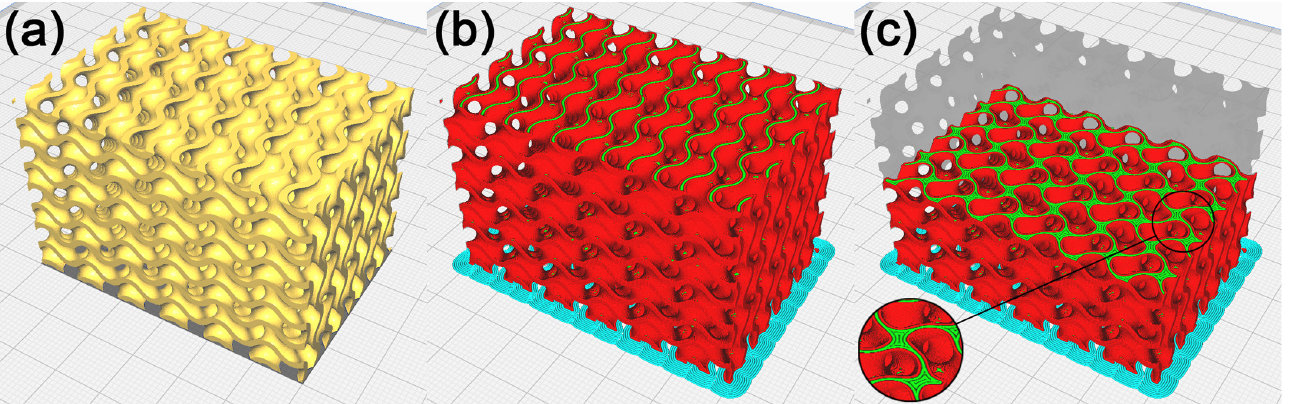
Figure 11. Cellular structure model with removed self-intersected surfaces inside the model. ( a ) Model in Cura, ( b ) illustration of the toolpath process of production by FDM technology, and ( c ) illustration of the toolpath in the model’s inner layer.